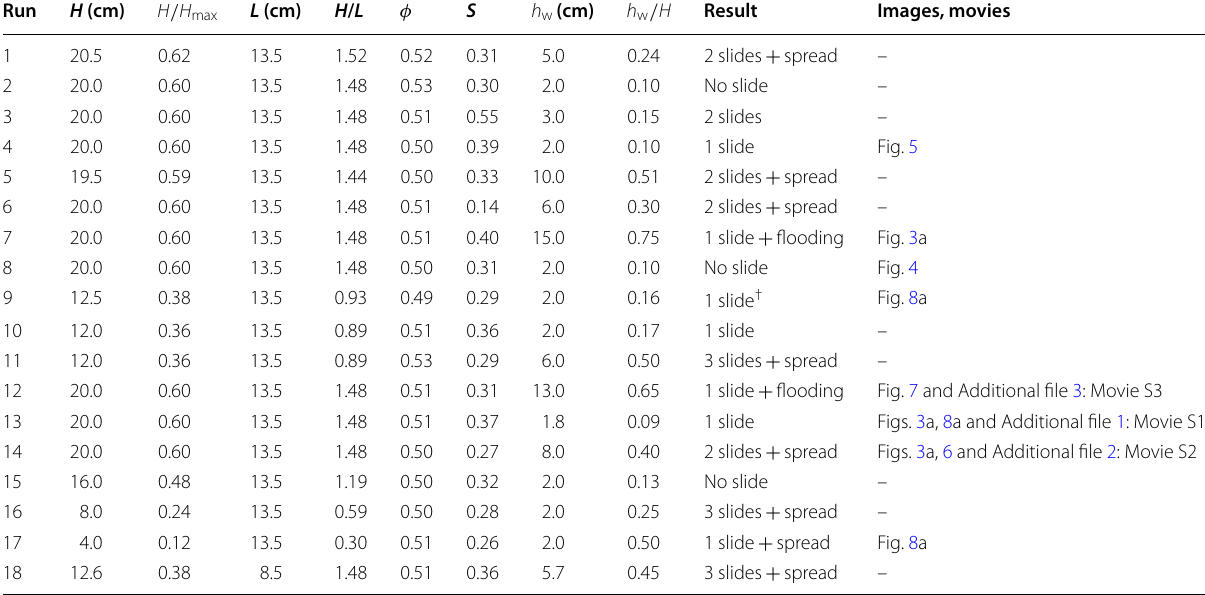
Table 2 A summary of the cliff landslide